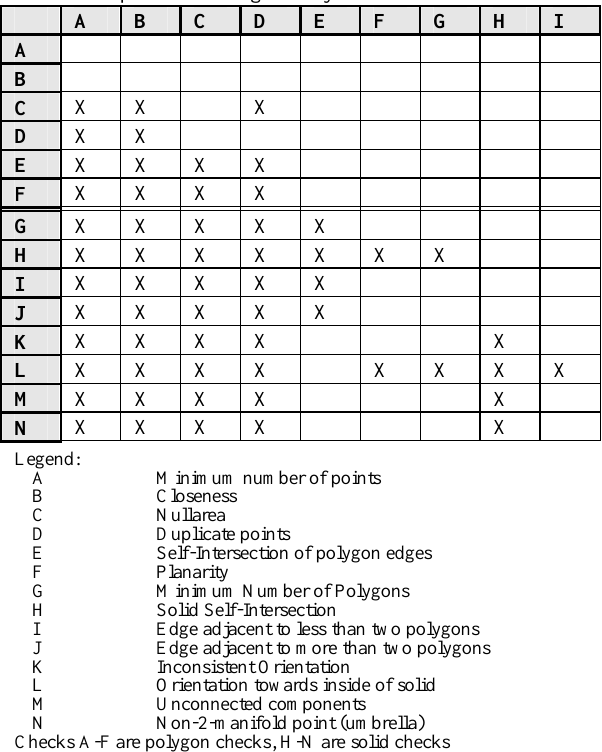
Table 1. Dependencies of geometry